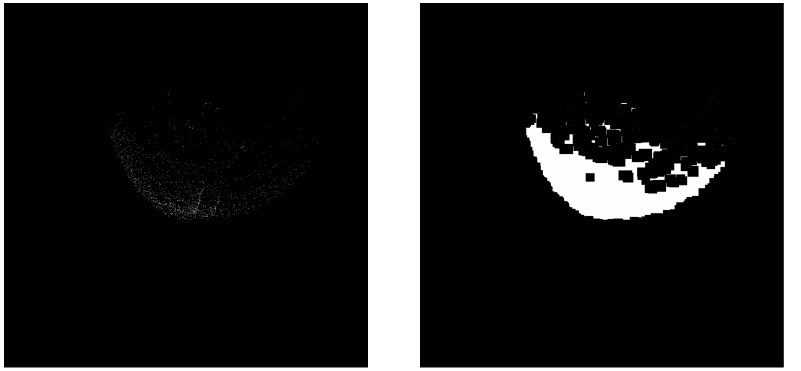
Figure 4. Image morphological